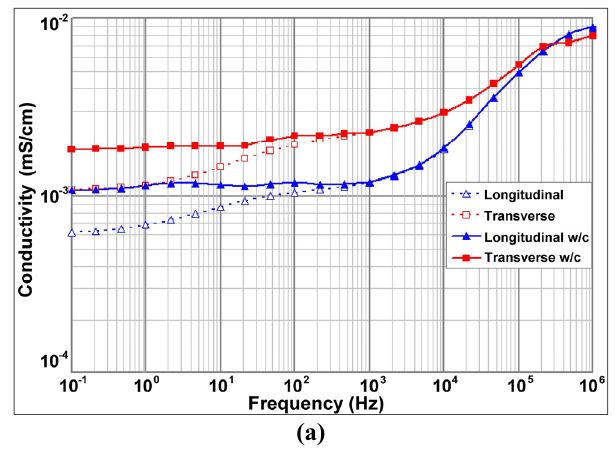
Figure 5: Values of IEA index between 0.1 Hz and 8 MHz. ( Δ : anisotropy values obtained with axial concentric electrode shape, □ : anisotropy values obtained with adjacent electrode shape).